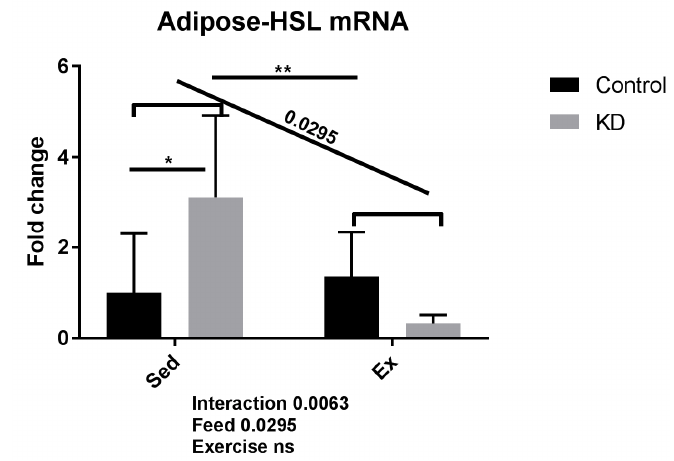
Figure 3. mRNA expression of lipolytic enzyme in adipose tissue immediately after exhaustion. HSL: hormone-sensitive lipase. ns: no significance observed. * p < 0.05 and ** p < 0.01. Significance between groups are marked using slashes.